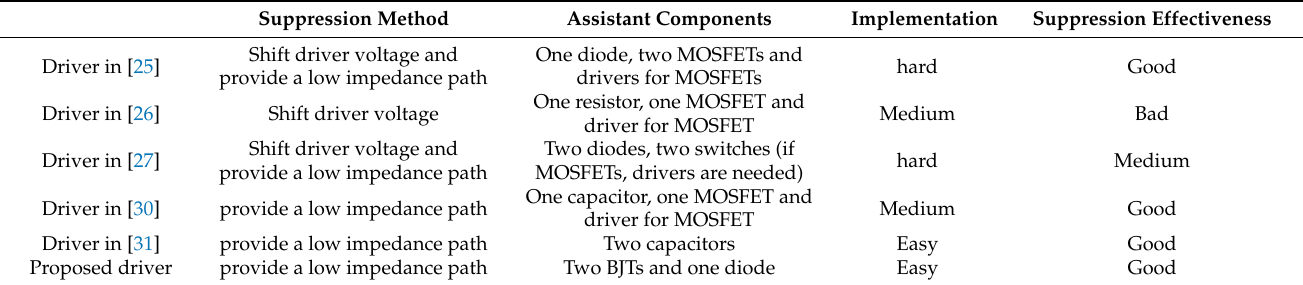
Table 4. Comparisons between the prior drivers in [25–27,30,31] and proposed driver.